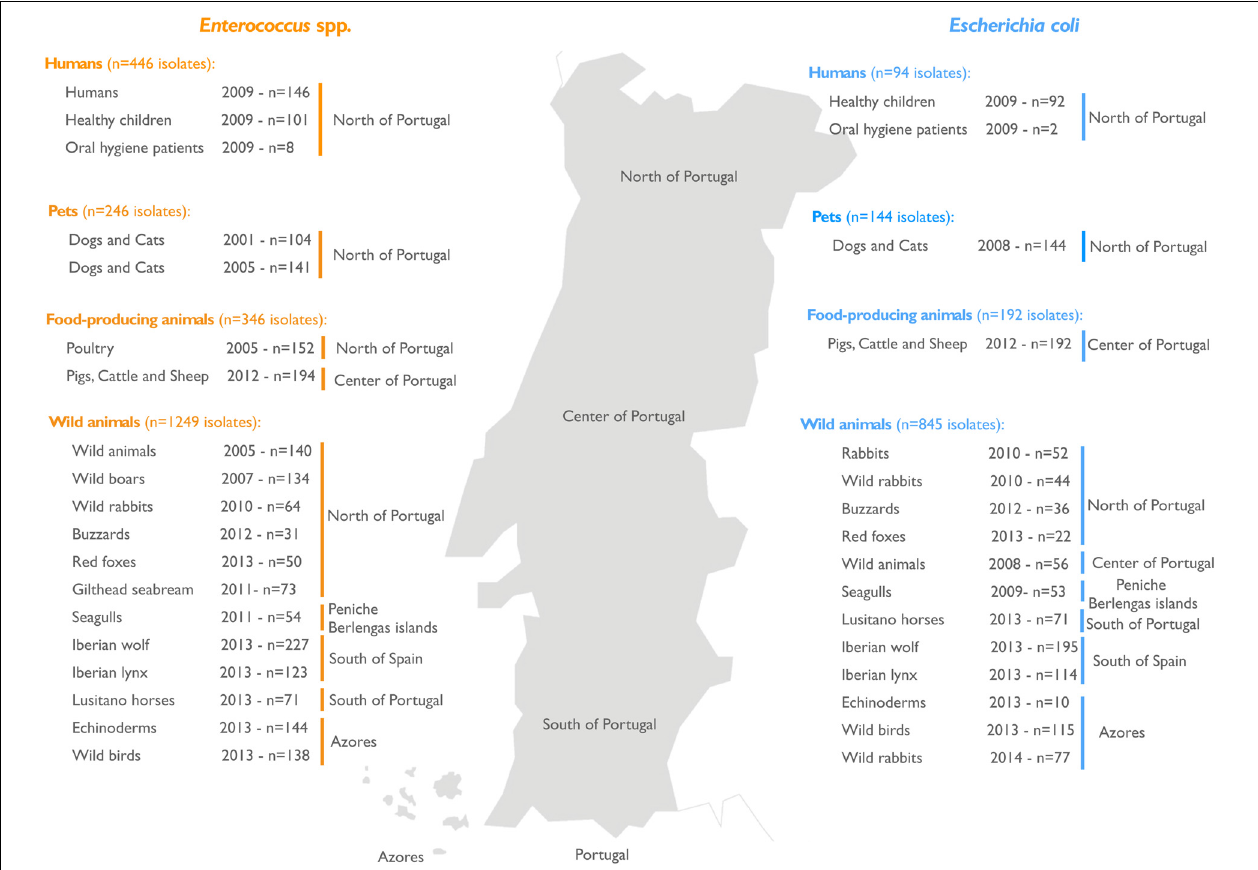
FIGURE 1 | Geographical distribution in Portugal showing the sources of samples containing bacterial isolates. The number and provenance of samples containing enterococci (orange) and Escherichia coli (blue) are shown. Both types of bacteria were frequently isolated from several samples from humans, pets, food-producing animals, and wild